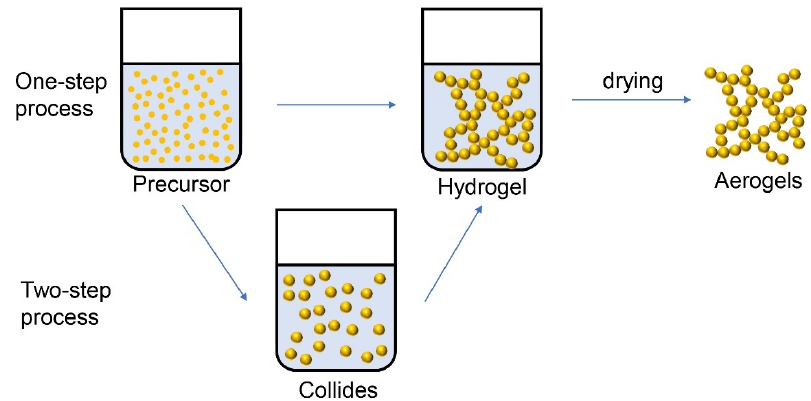
Figure 1. Two aerogel preparation processes.